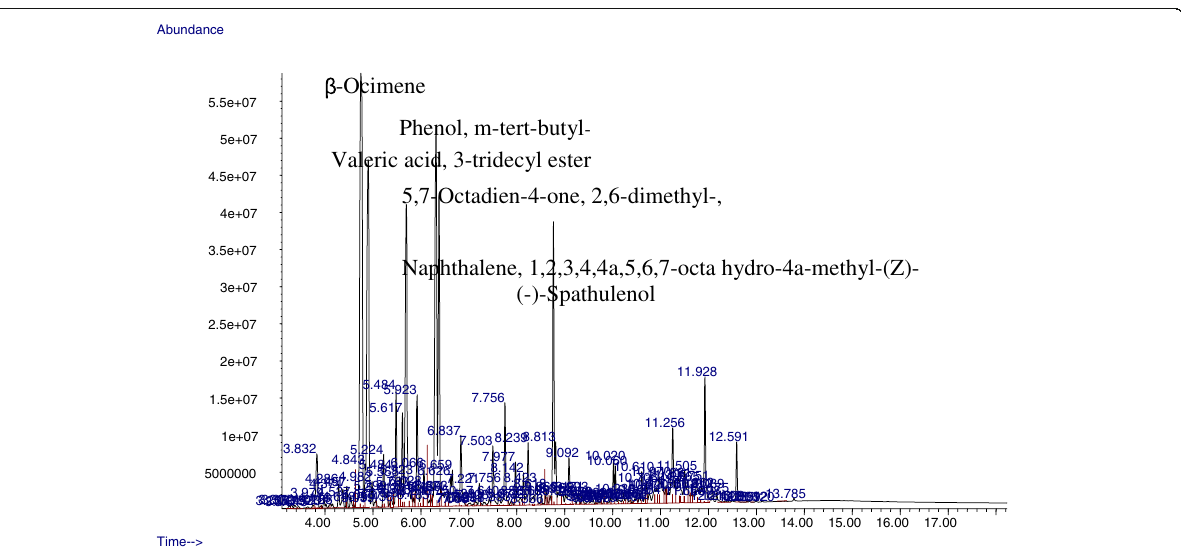
Fig. 1 GC-MS spectra of the six major compounds present in the EO of T.